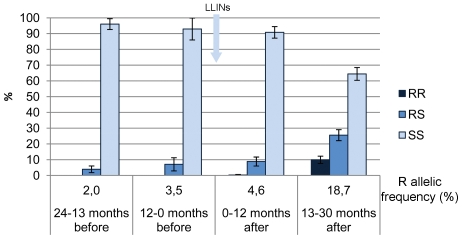
kdr mutation in An. gambiae before and after the implementation of LLINs.Proportion (and 95% CI) of An. gambiae with L1014F homozygote mutation (RR), heterozygote mutation (RS) or wild type (SS) sampled 24-13 months (n = 228) and 12-0 months (n = 99) before the implementation of long lasting insecticide-treated nets (LLINs) in July 2008, 0–12 months (n = 327) and 13–30 months after (n = 582).